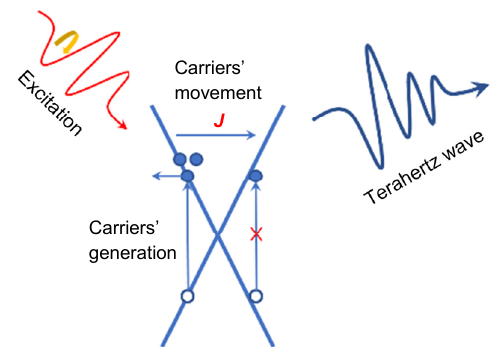
Fig. 2 | Schematic view of helicity-dependent terahertz radiation